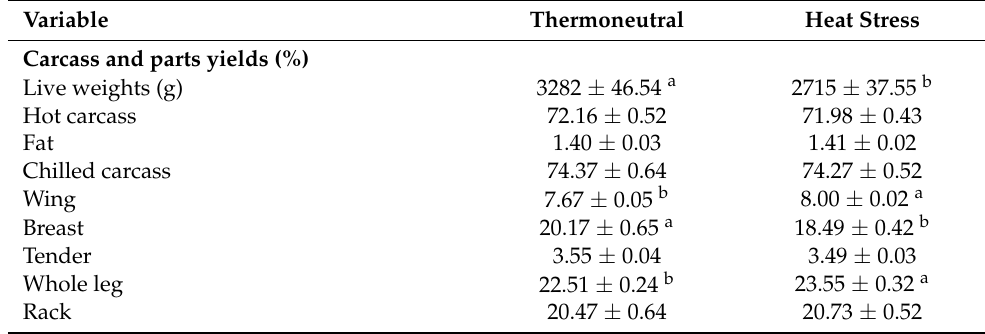
Table 2. Carcass and part yields (%), muscle myopathy scores, and meat quality attributes of broilers from thermoneutral and cyclic heat stress groups in trial